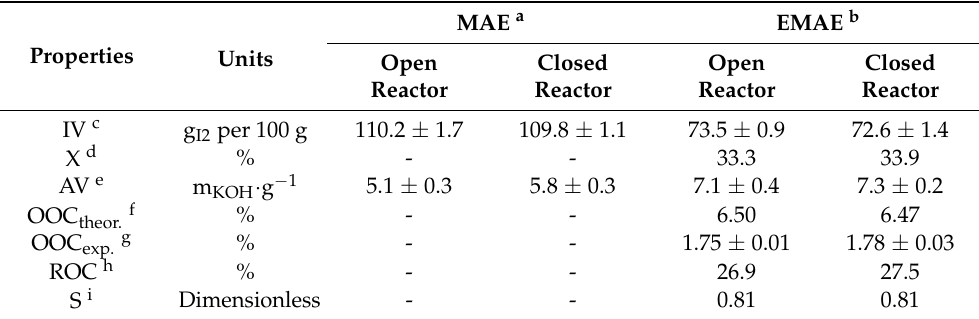
Table 2. Chemical properties of used soybean cooking oil (USCO), monoalkyl esters (MAE) and epoxidized monoalkyl esters (EMAE) produced in this